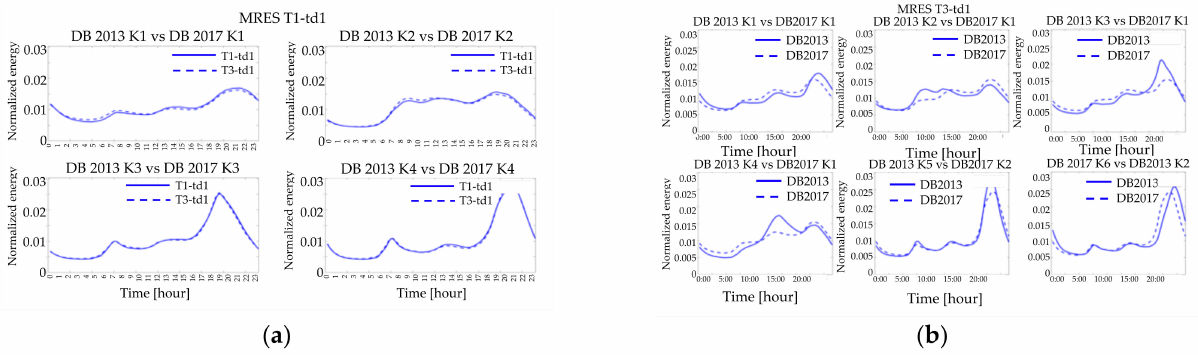
Figure 16. Main residence contract (MRES) costumer, comparison between normalized centroids of the two databases (DB2013 vs. DB2017): ( a ) winter workdays, ( b ) summer